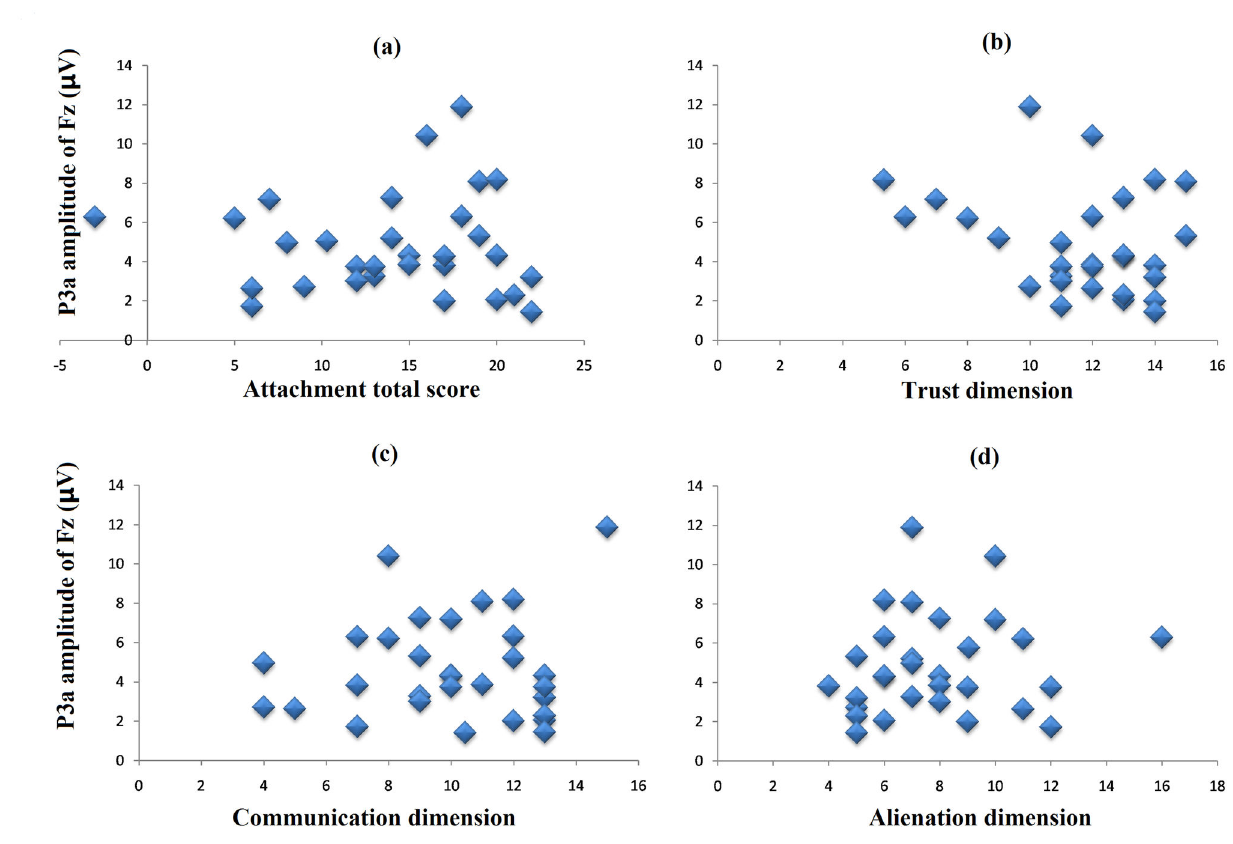
Figure 5. The correlations between the maternal attachment scores and the P3a amplitudes evoked by the mother’s face. Any significant correlations were found in the case of the mother (total score: r = .11, p = .302, Figure 5a; trust dimension: r = .10, p = .311, Figure 5b; communication dimension: r = .003, p = .495, Figure 5c; alienation dimension: r = .04, p = .423, Figure